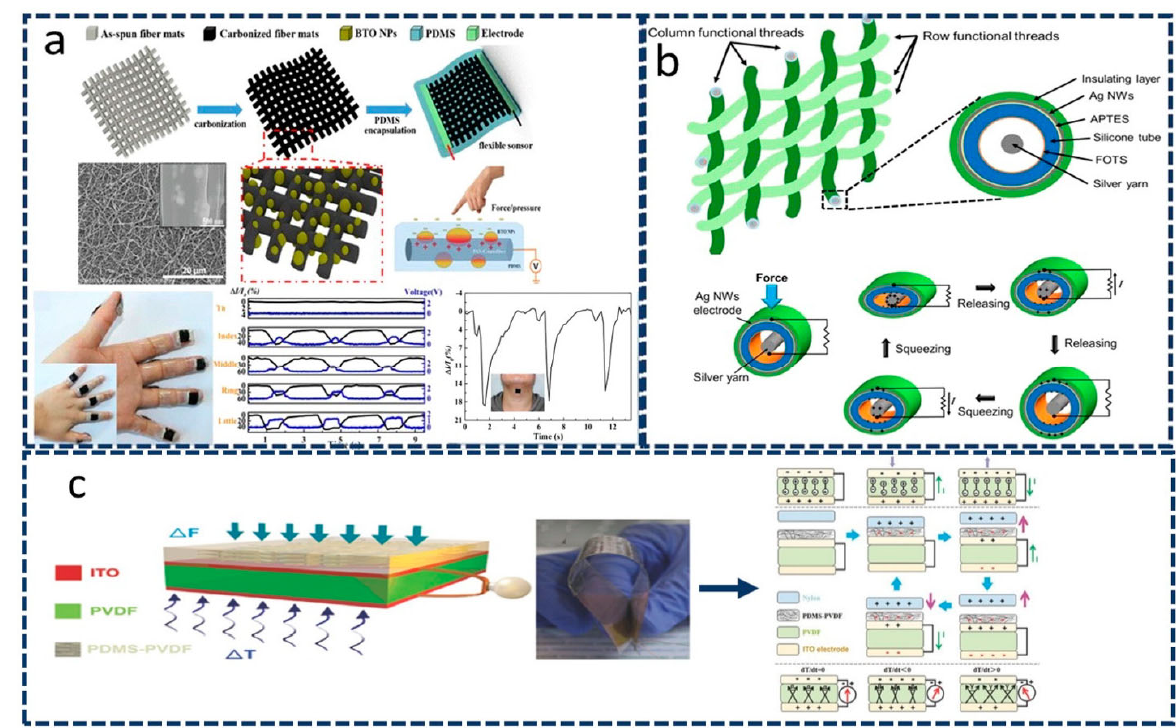
Figure 4. Three ‐ principle integrated wearable sensors. ( a ) Carbonized electrospun nanofiber films composed of polyacrylonitrile/barium titanate (PAN ‐ C/BTO) have been developed for the fabrication of multifunctional sensors. Reproduced with permission from the American Chemical Society (2018) [49]. ( b ) A power ‐ generation sensor was obtained by integrating triboelectric, capacitive, and resistive mechanisms. Reproduced with permission from MDPI (2017) [50]. ( c ) A flexible multifunctional sensor combining piezoelectric, triboelectric, and pyroelectric effects. Reproduced with permission from Wiley (2016) [51].